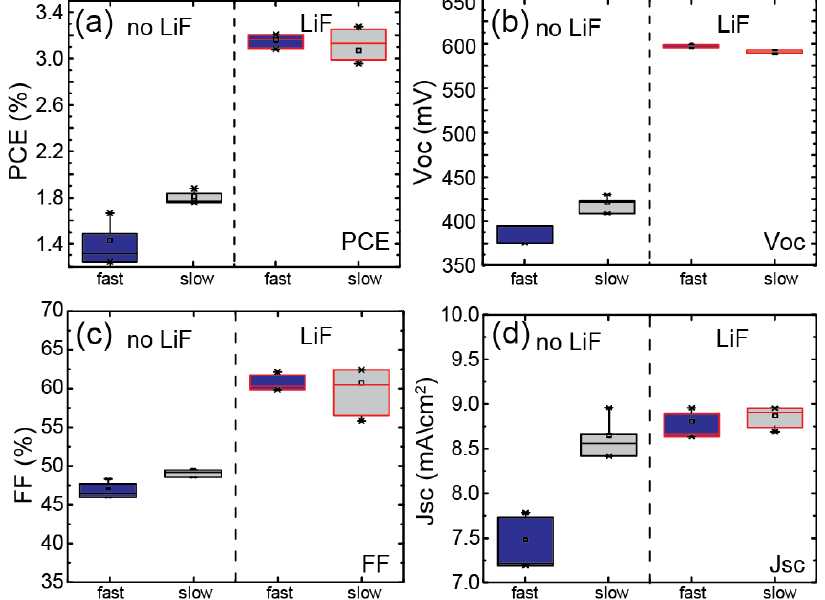
Figure 2. Box plots for the ( a ) power conversion efficiency, ( b ) open circuit voltage, ( c ) fill factor, and ( d ) short-circuit current, for fast and slow drying of P3HT:PCBM solar cell films, with and without a LiF interlayer. Data incorporate results from 10 devices. Adapted from Ref. [85] with the permission of AIP